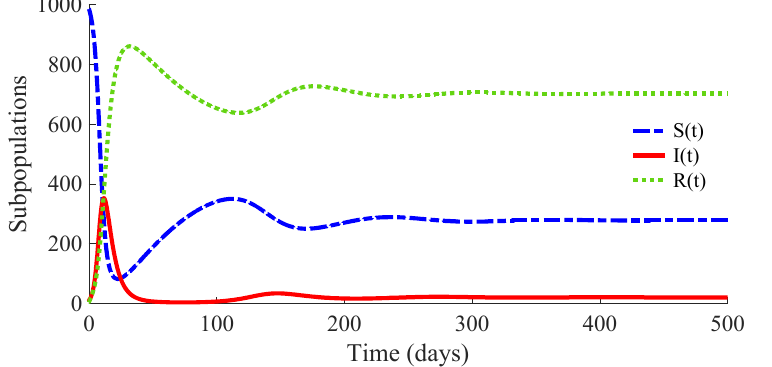
Figure 8. Time evolution of the subpopulations in the SIRS model under an insufficient vaccination and treatment. The time evolution of the control efforts is displayed in Figure 9.